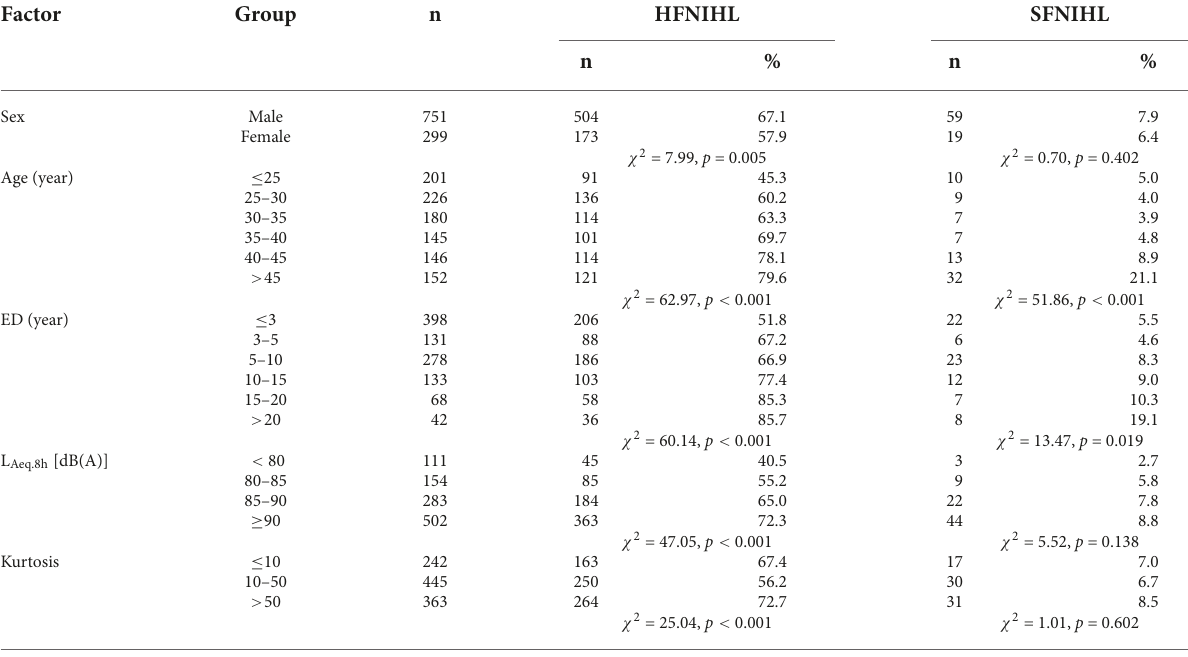
TABLE 2 Principal characteristics of HFNIHL and SFNIHL among workers in manufacturing industries ( n = 1,050). Factor Group n HFNIHL SFNIHL n % n % Sex